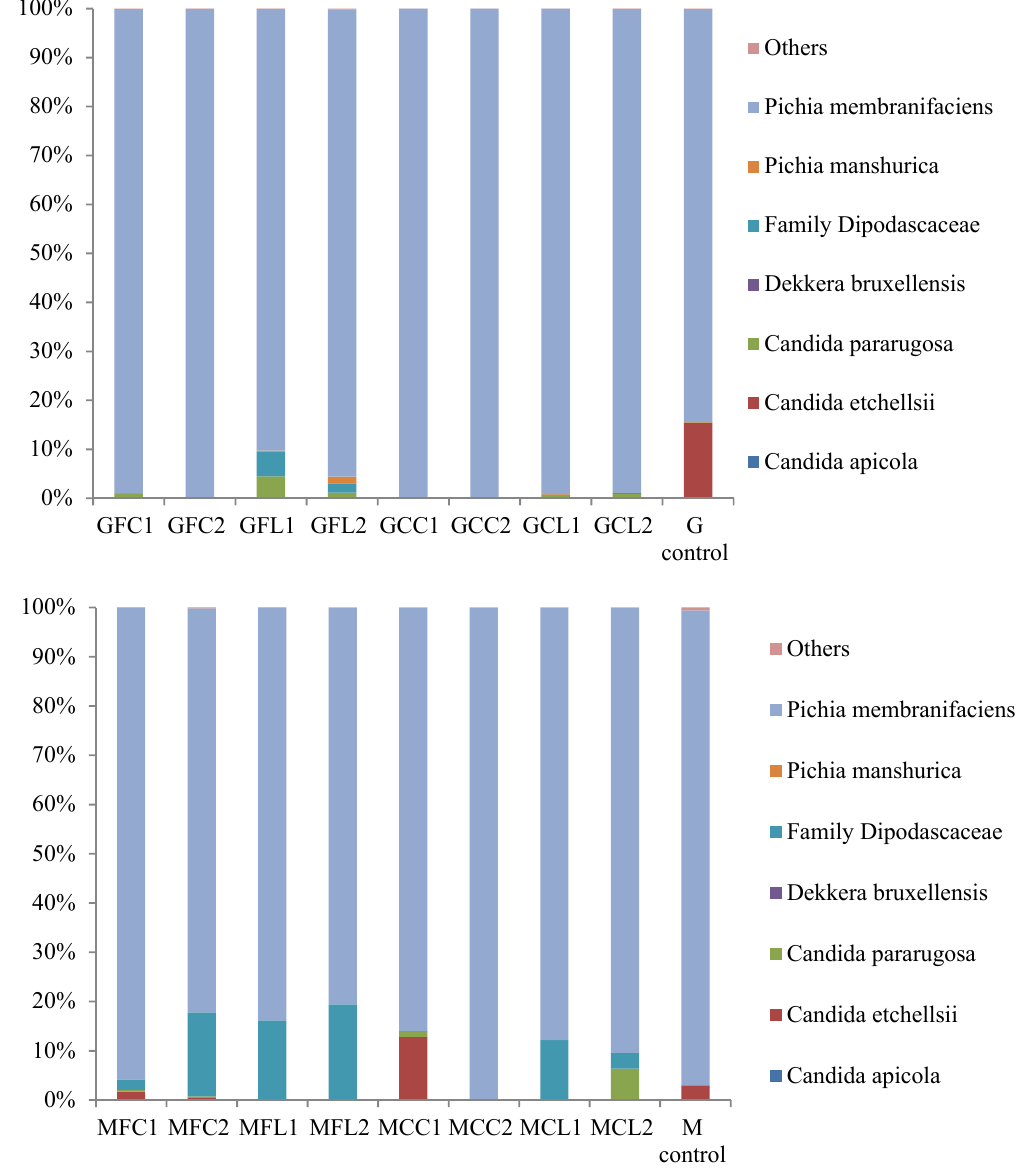
Figure 4. The relative abundance (%) of the fungal species or family obtained by the pyrosequencing analysis at the post-fermentation stage. The results of the G and M controls correspond to a blend of both duplicates. See Table 5 for the meanings of the samples abbreviations.